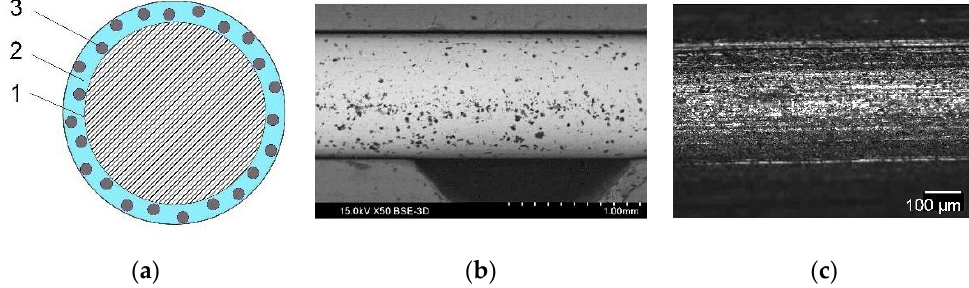
Figure 6. Wire with composite coating: ( a ) The design of the composite wire: (1) solid wire, (2) Ni-matrix, (3) nanoparticles of REE compounds; ( b ) SEM and ( c ) optical macrostructure of the composite Ni-coating on the surface of the wire with particles of lanthanum boride, LaB 6 .